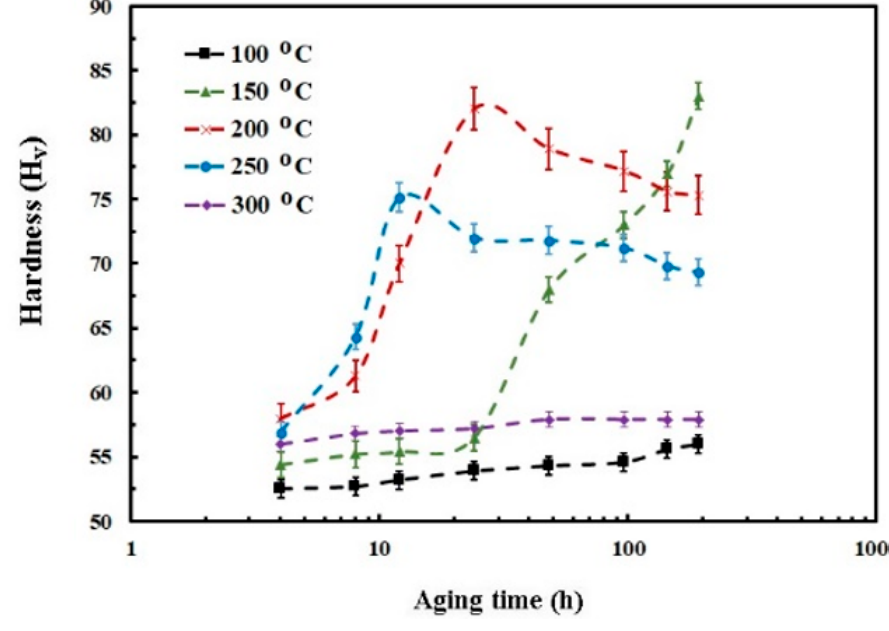
Figure 4. Age-hardening curves of AZ91 magnesium alloy aged at different temperatures.